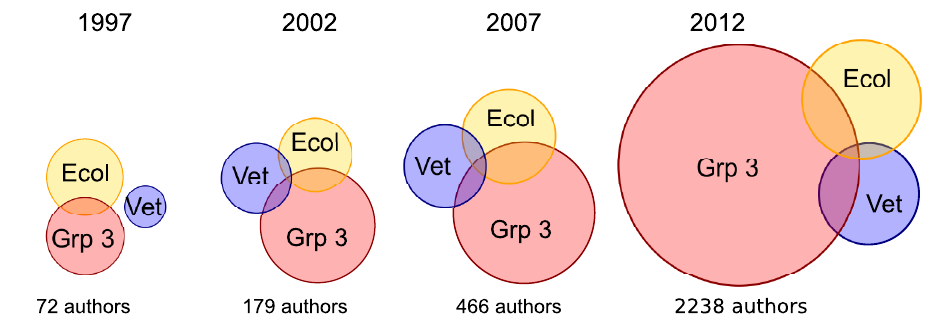
Fig 2. Venn diagrams of cross-community authorship through time. Each year ’ s Venn diagram is scaled to reflect the number of authors with two or more papers in our paper bank over the preceding 5 y. Number of authors with two papers in the same journal community are represented by disjointed regions of the circles, and number of authors with papers in two different communities are represented by the area of the intersections. Each circle is scaled to reflect the total number of authors with papers in that community during the 5 y prior to the label year. Areas are on a log-scale, and total number of authors with multiple papers each year is reported below each Venn diagram. Data to generate this figure are contained in S1